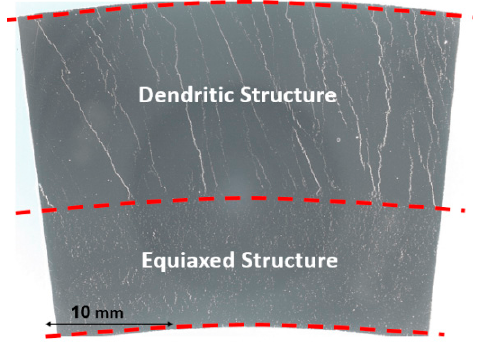
Figure 3. Stereomicroscope image of the cross section of the failed tube.